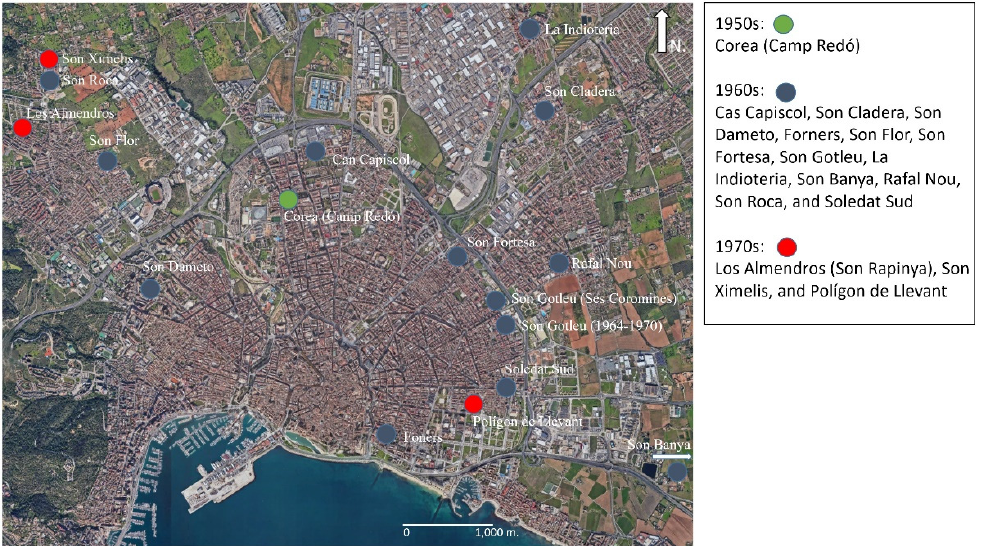
Figure 4. Location of the main public housing developments built by the Housing Ministry in Palma during the developmentalism period (1950s to 1970s). Source: Prepared by the author based on the MUIB (Balearic Urban Map) and Ajuntament de Palma.